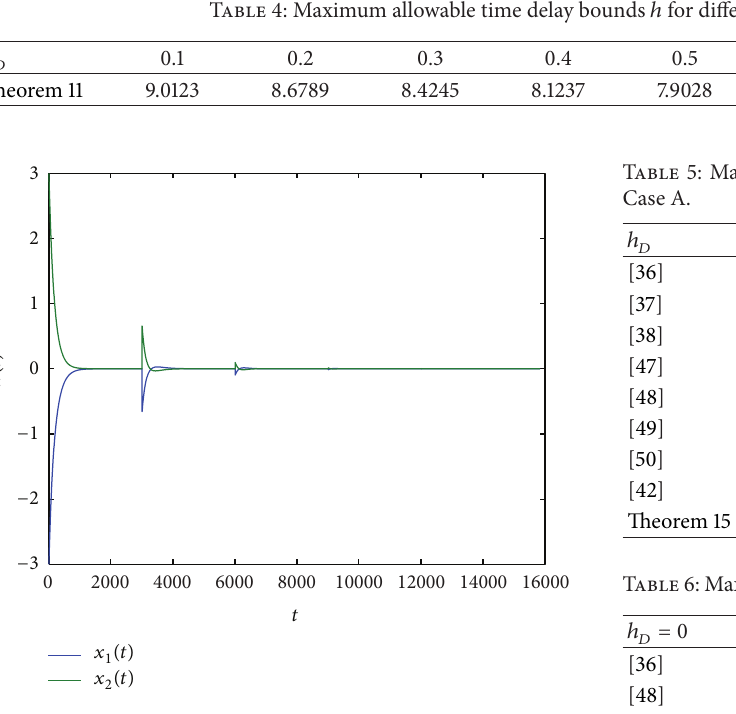
Figure 4: The simulation of Example 3 for ℎ = 𝑟 = 9.0123 , where the initial value is [−3,3] 𝑇 , ℎ 𝐷 = 0.1 .